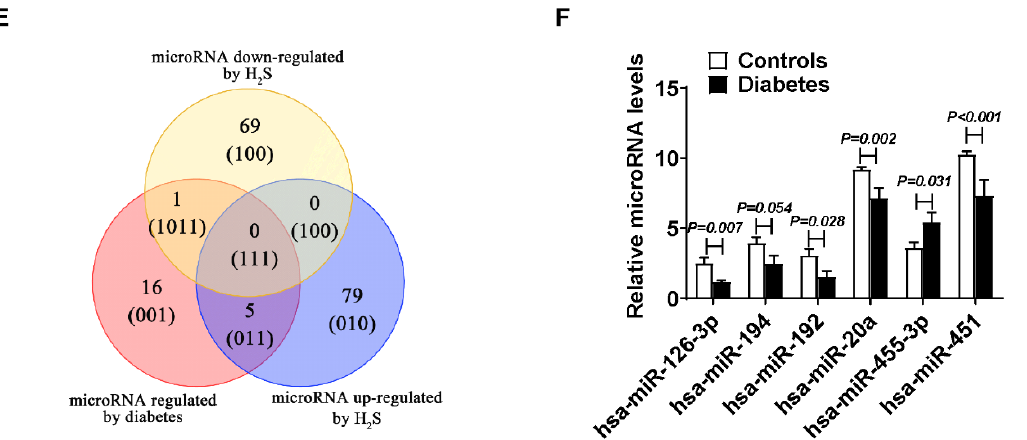
Figure 2. The microRNAs regulated by diabetes and exogenous H 2 S. ( A ) Volcano plot of the expressed microRNAs in the plasma between the control and diabetic patients; n = 10. ( B ) Heat map of the expression levels of 22 dysregulated microRNAs. Each row represents a microRNA and each column represents a sample. ( C ) Heat map of the microRNA expression levels up-regulated by NaHS (30 µ mol/L). ( D ) Heat map of the microRNA expression levels down-regulated by NaHS (30 µ mol/L). ( E ) Venn diagram of the significantly upregulated or downregulated microRNAs between diabetes- induced dysregulated microRNAs and H 2 S-regulated microRNAs. ( F ) Statistical analysis of the dysregulated microRNA expression in plasma induced by diabetes and also regulated by H 2 S; n =